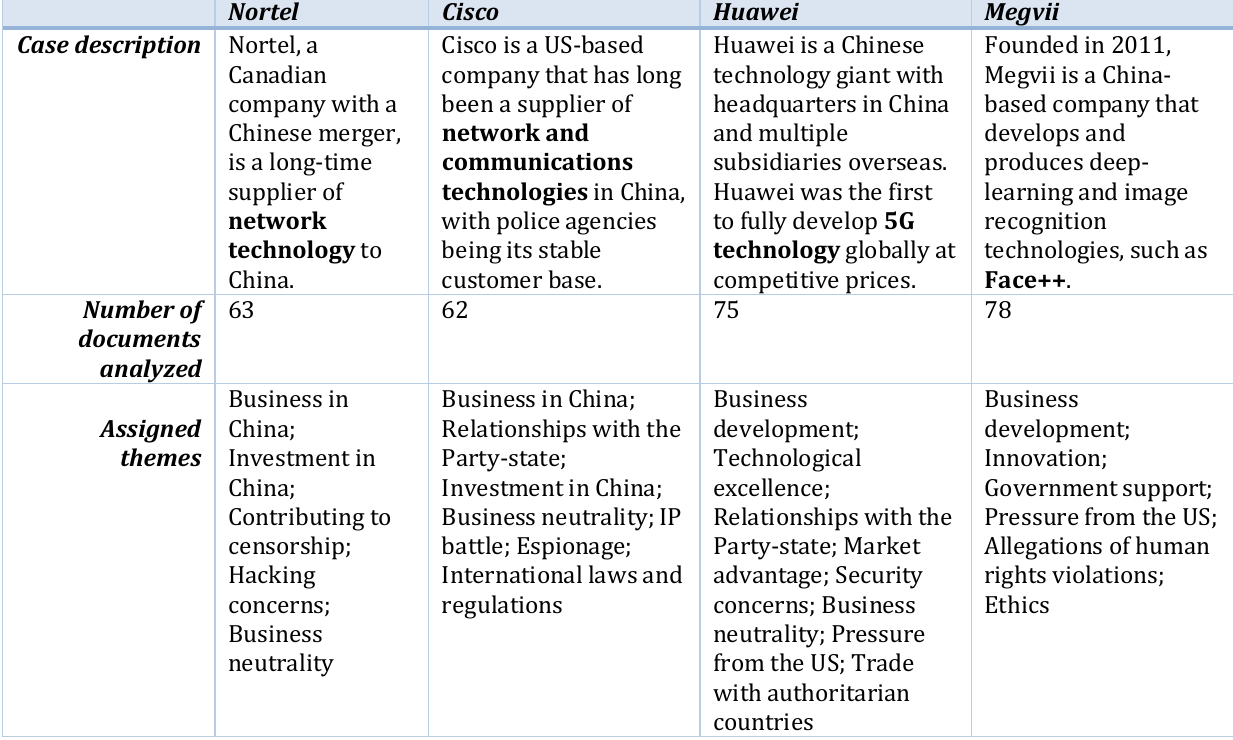
Table 1. Case study definitions and details